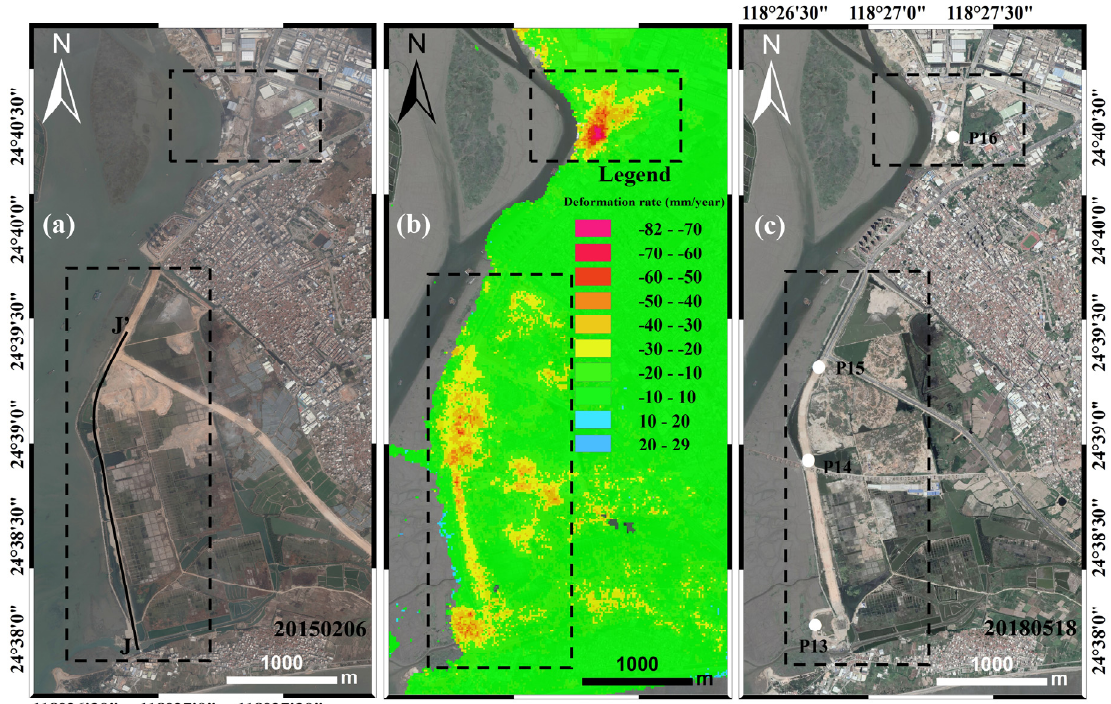
Figure 12. Ground deformation rate and remote sensing images of Region G. ( a ) Remote sensing image acquired on 6 February 2015; ( b ) average deformation rate map in the LOS direction from January 2017 to October 2018; ( c ) remote sensing image acquired on 18 May 2018.